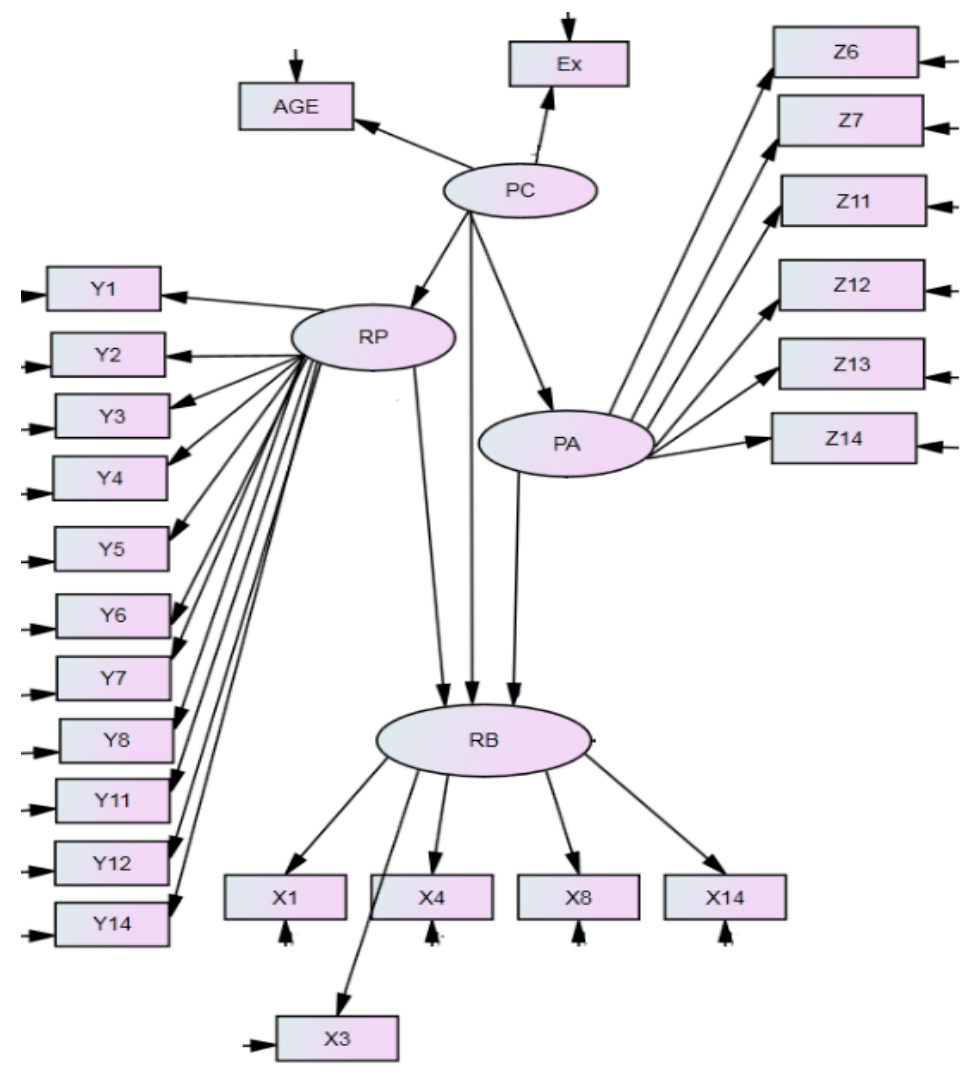
Figure 5. Relationship of latent variables components in Structural Equation Modeling (SEM).